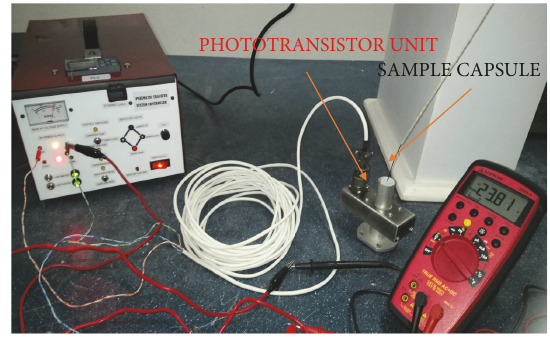
Figure 16: Phototransistor detects sample capsule, output +24 VDC.